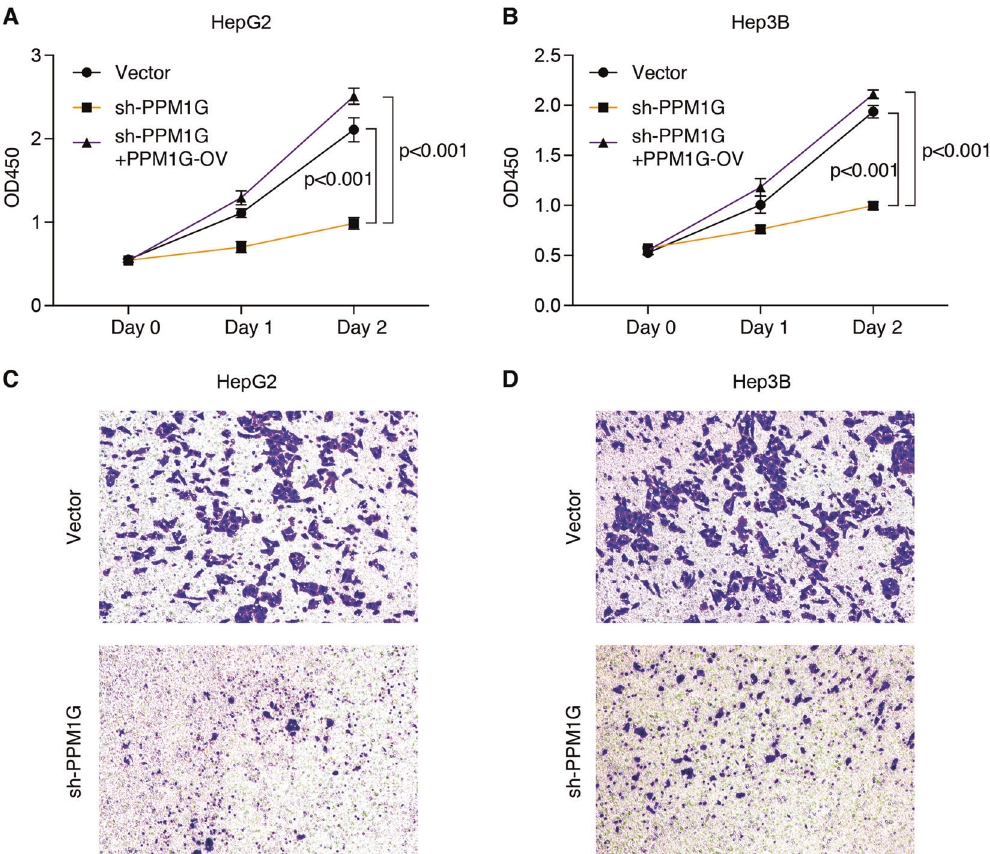
Fig. 3 Knockdown PPM1G inhibited cell proliferation and invasion of HepG2 and Hep3B cells. A – B Knockdown PPM1G inhibited the cell growth of HepG2 and Hep3B. HepG2 and Hep3B cells were transfected with shRNA targeting the PPM1G, or co-transfected with PPM1G shRNA and PPM1G overexpression plasmid. Viable cells were examined at 0-, 1-, and 2-days post transfection by CCK-8 assays. C – D Knockdown PPM1G inhibited the invasion of HepG2 and Hep3B cells. HepG2 and Hep3B cells were transfected with shRNA targeting the PPM1G and the invasion was determined by transwell